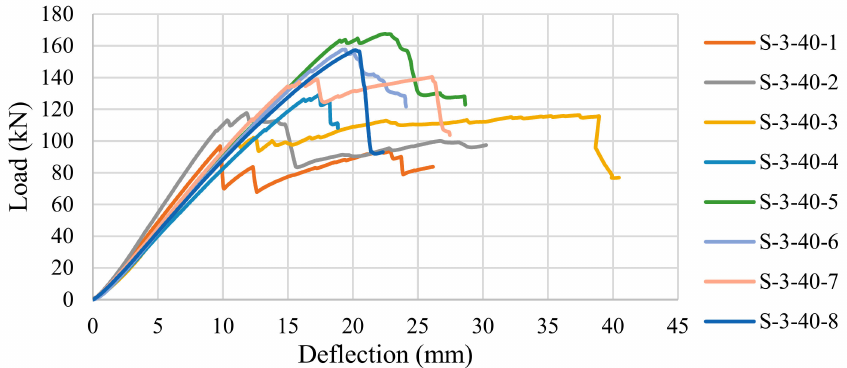
Figure 9. Panel configuration S-3-40: deflection to failure load